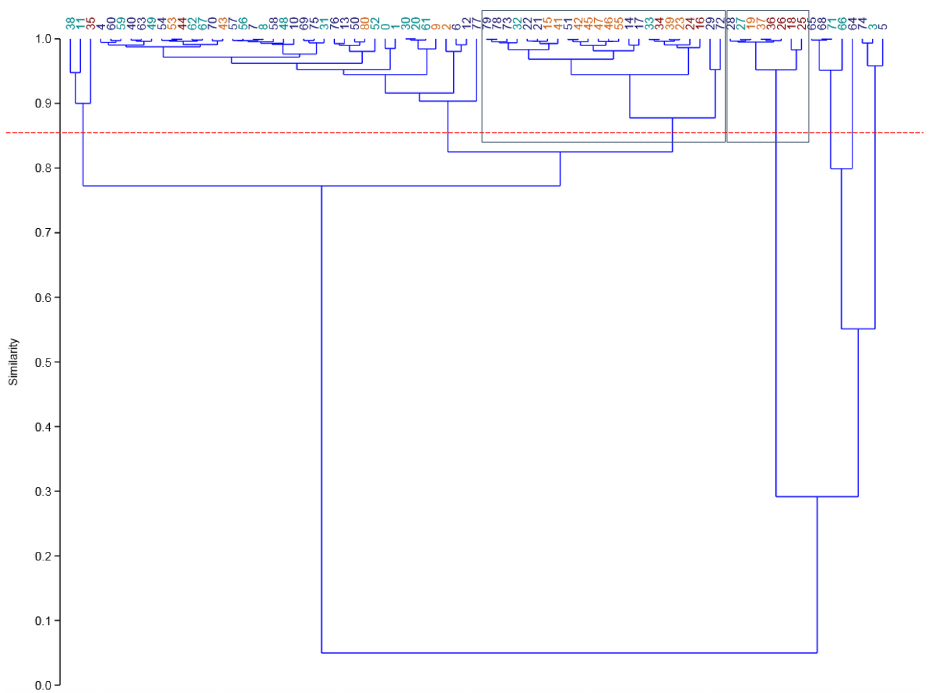
Figure 1. Cluster analysis of sampled sites. Groping is made via